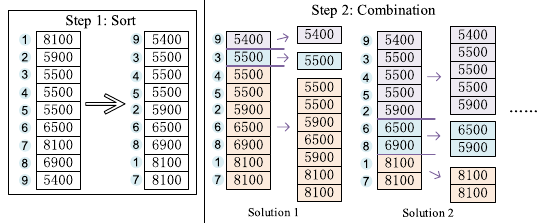
Fig. 6 Search process for the optimal module connection